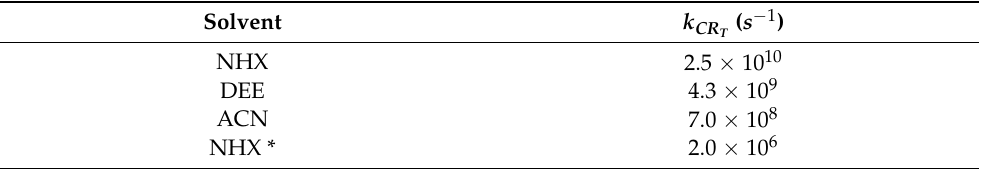
Figure 2. Lewis structure of PyrDMA as well as a 3D representation (Chimera) showing the orthog- onality of the donor and acceptor (DFT optimized structure in the ground state).